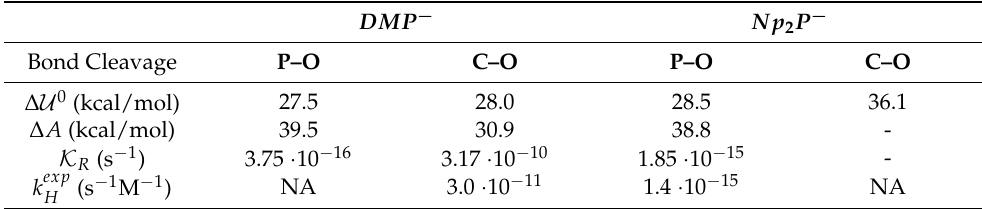
Table 2. Comparison of the hydrolysis of DMP − and Np 2 P − . ∆ U 0 corresponds to the unperturbed electronic energy barrier and ∆ A to the free energy barrier. DMP − Bond